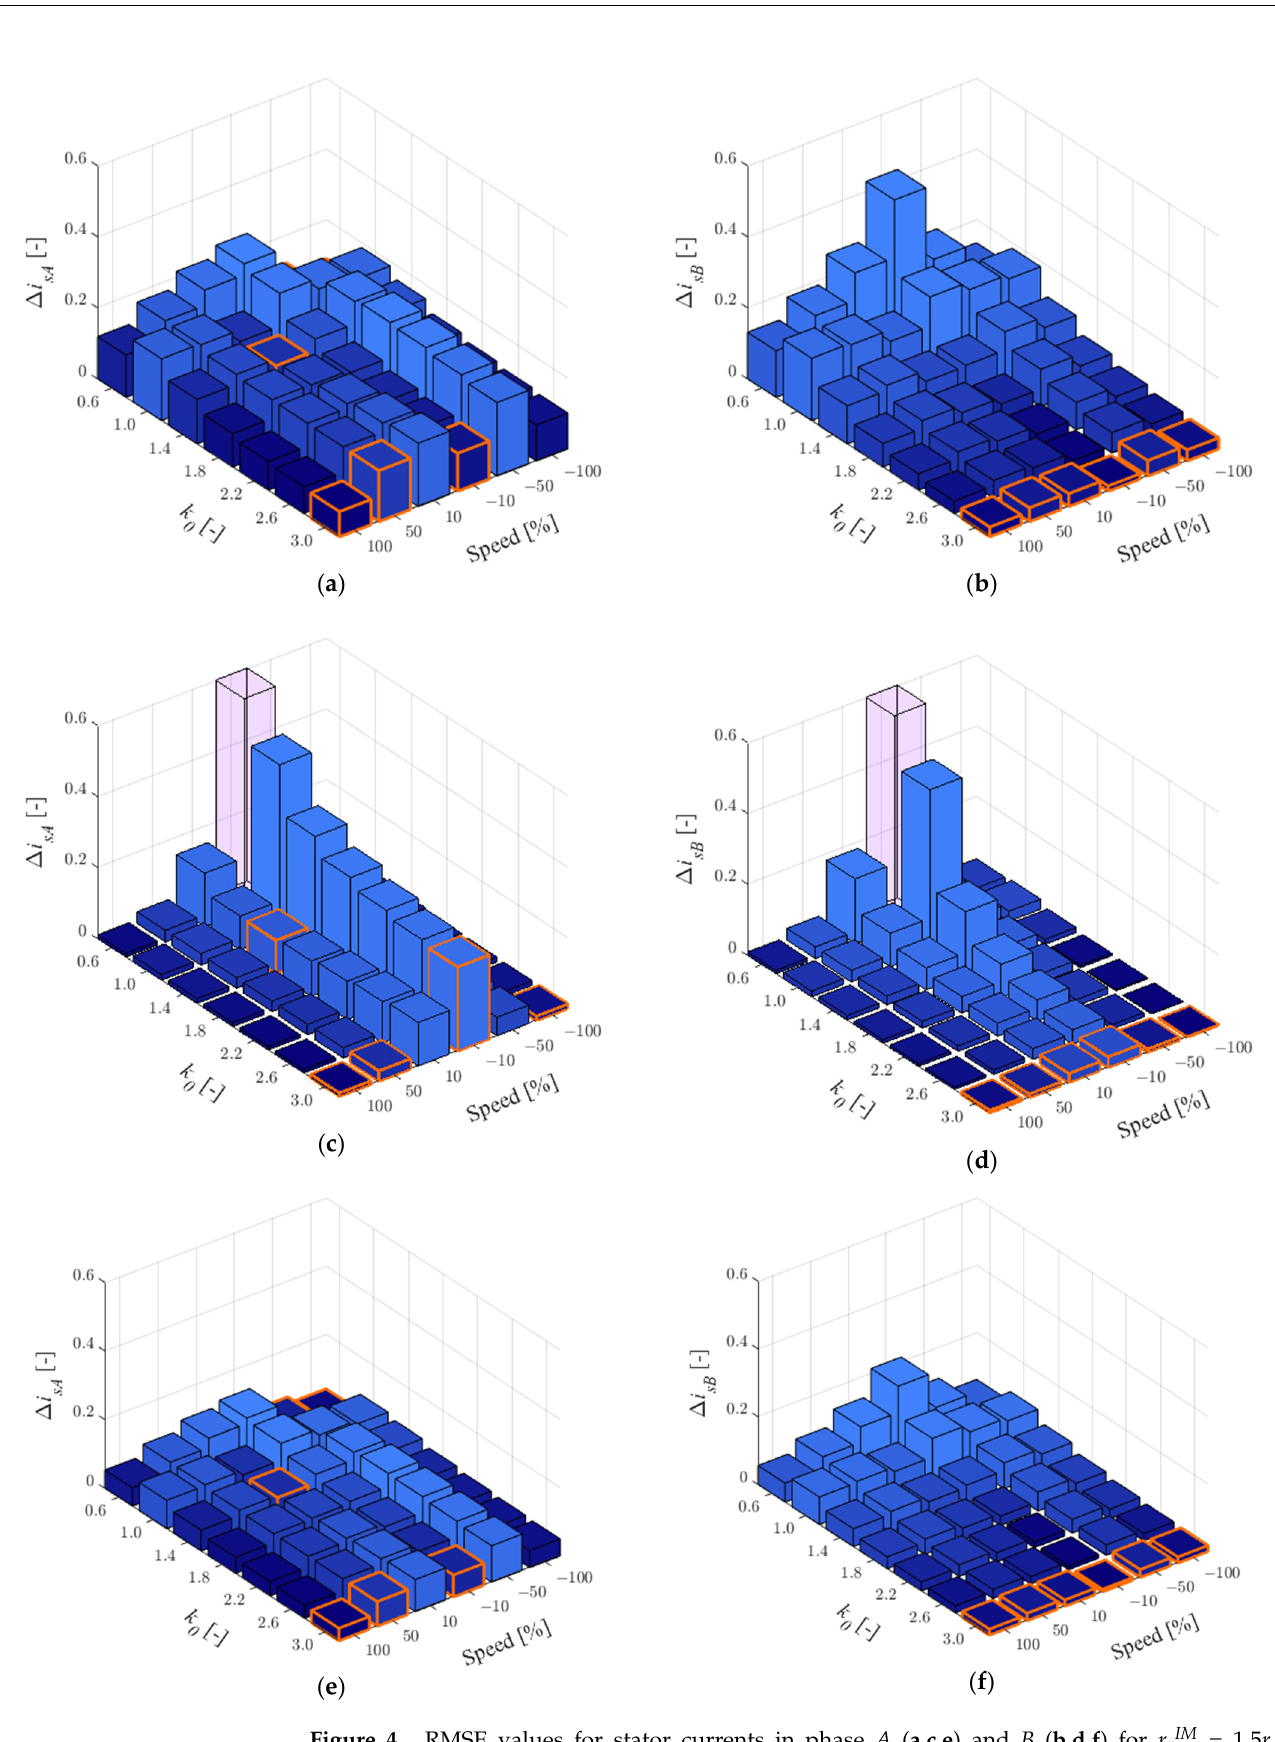
Figure 4. RMSE values for stator currents in phase A ( a , c , e ) and B ( b , d , f ) for r rIM = 1.5 r